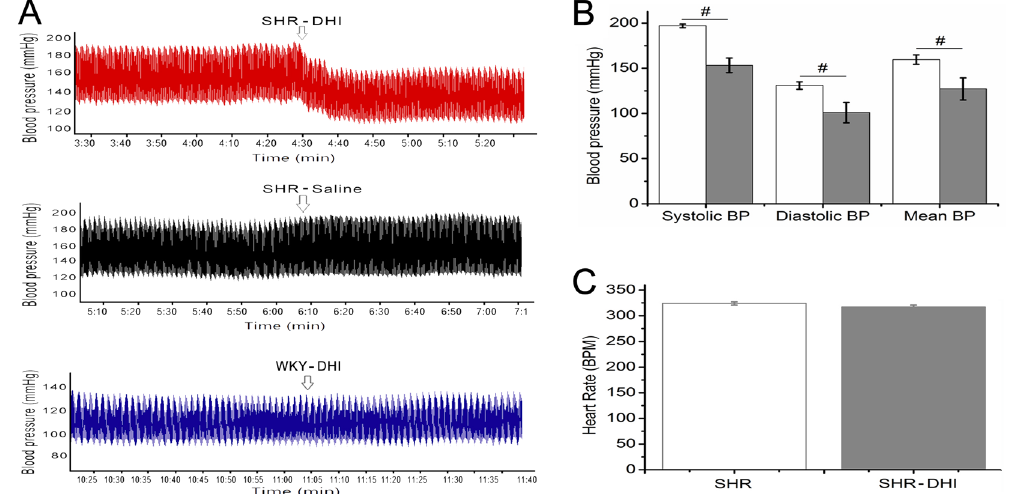
Figure 2. Effects of DHI on invasive blood pressure in SHR. Invasive BP were measured in urethane anaesthetised rats after treatment with DHI. A heparinized saline, 100 IU/mL was filled in the transducer in clean polyethylene catheter cannulated to the ventricle through the left common carotid artery. DHI decreased BP in SHR (p < 0.01, Fig. 2A [SHR (DHI)] and 2B, n = 3) but did not change the heart rate (p > 0.05, Fig. 2C). DHI did not change BP in normotensive WKY rats (p > 0.05, Fig. 2A [WKY